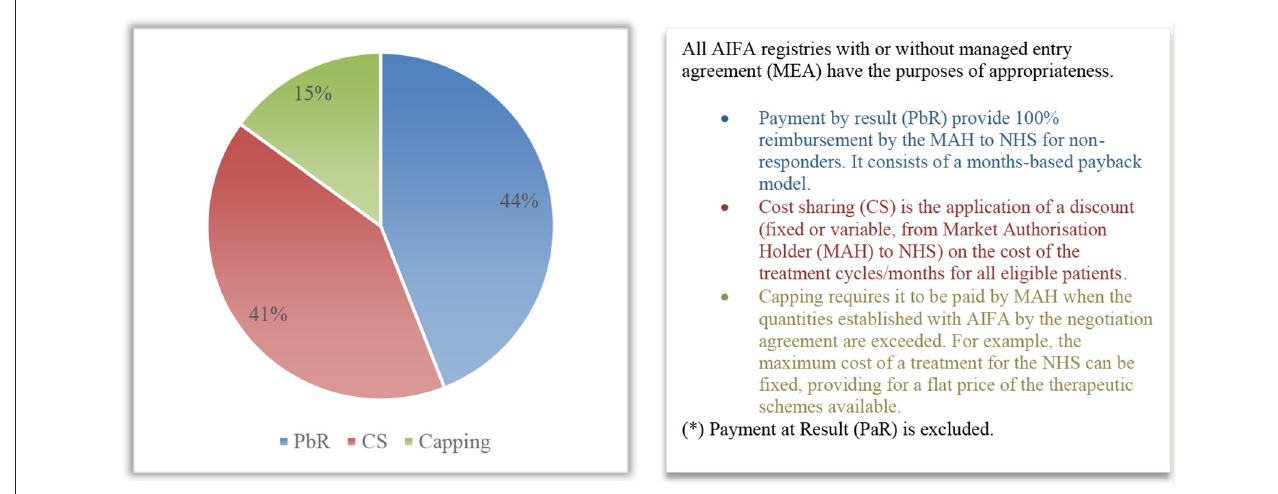
FIGURE 2 | Distribution (%) of the types of MEA (*) patient-level for 2020 within AIFA registries.